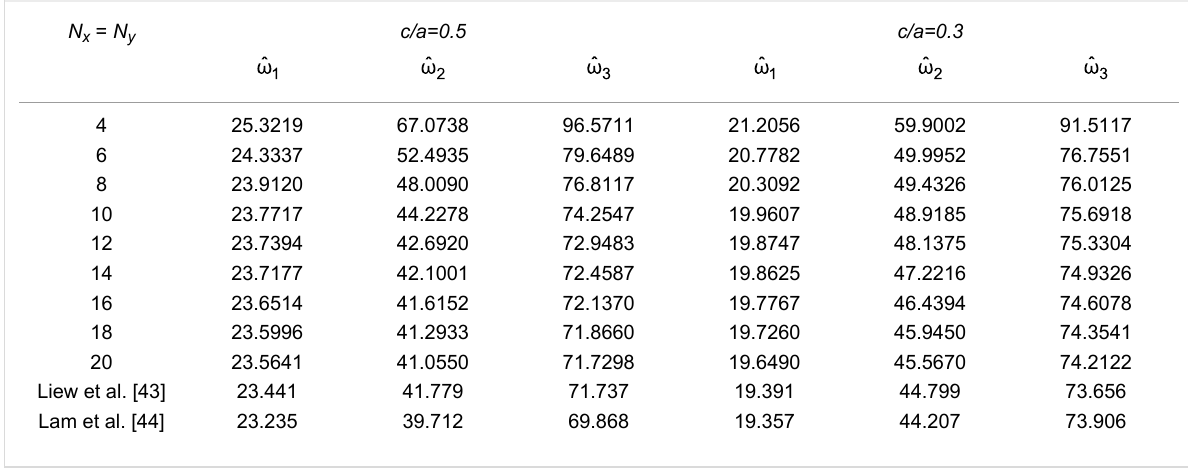
Table 2: Convergence study on the first three frequency parameters of SSSS isotropic homogeneous square plates with a/h = 100, ν = 0.3 and two cutout